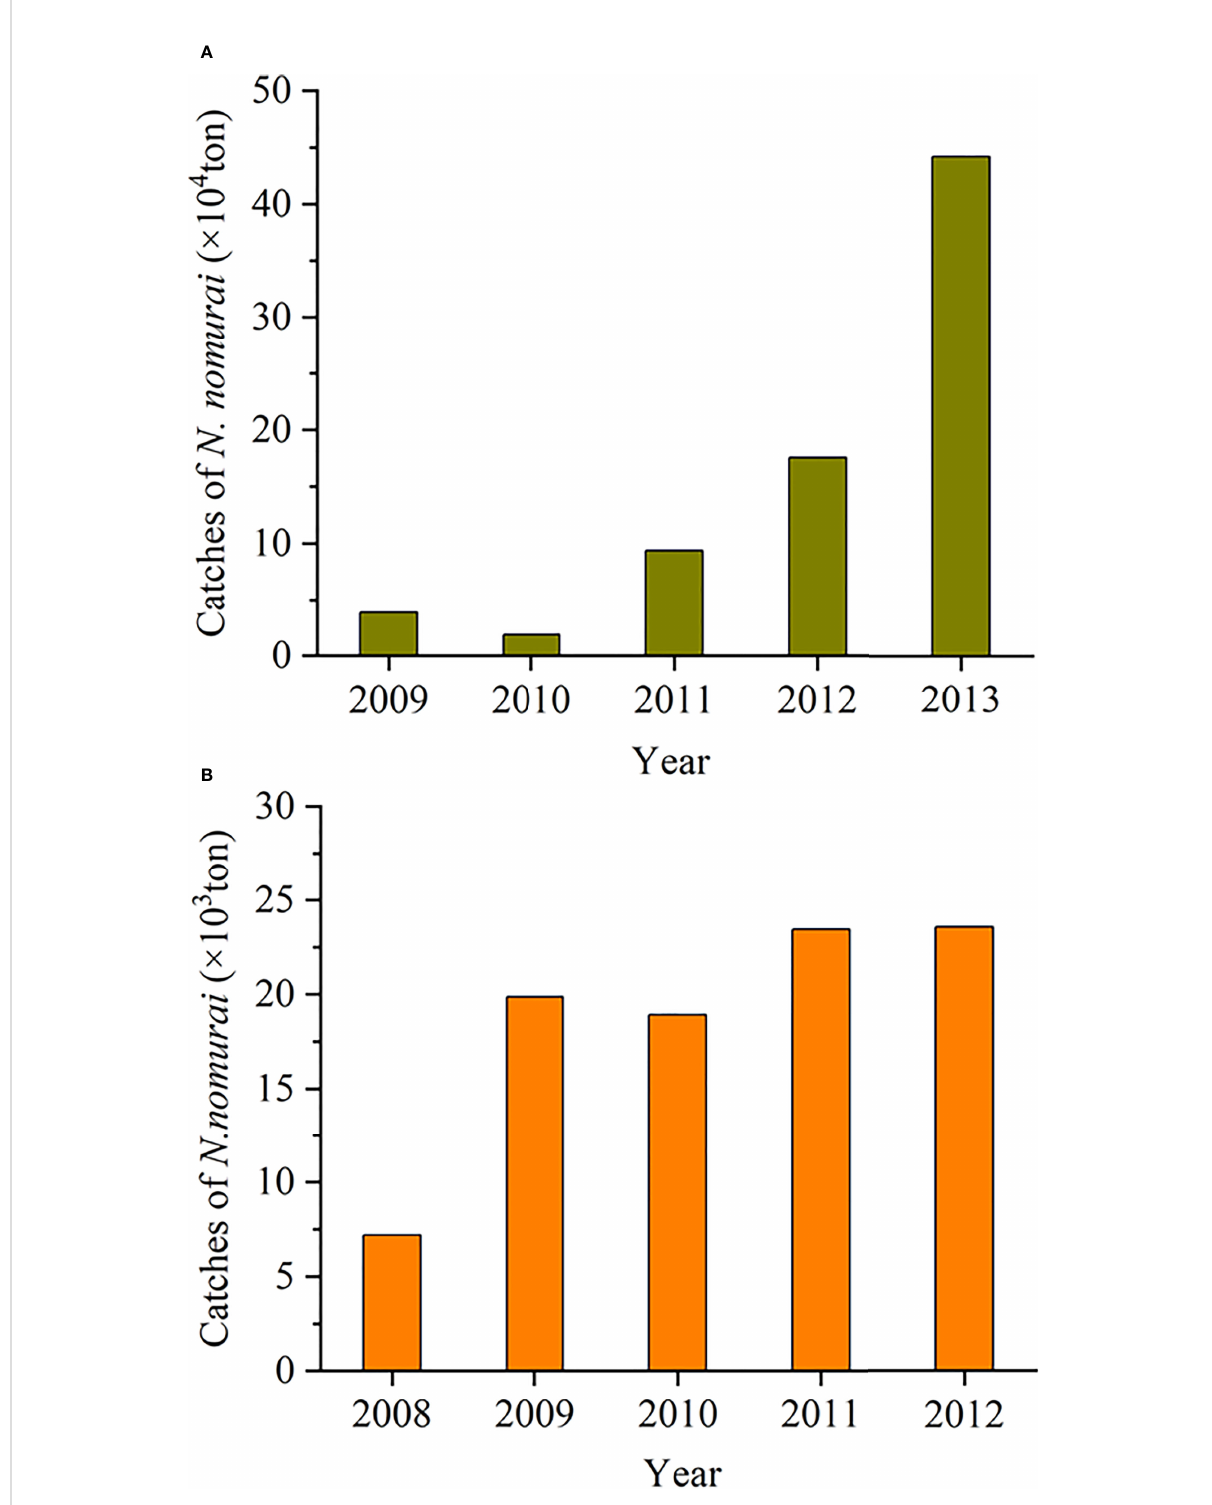
FIGURE 5 Changes in the annual catches of Nemopilema nomurai in the Bohai and Yellow seas from 2009 to 2013 (A) and in Tangshan, Hebei Province, China from 2008 to 2012 (B) . The data are from Report on China ’ s marine fi shing situation, Li et al., 2014, and Zheng et al., 2014. The location of Tangshan is marked in Figure